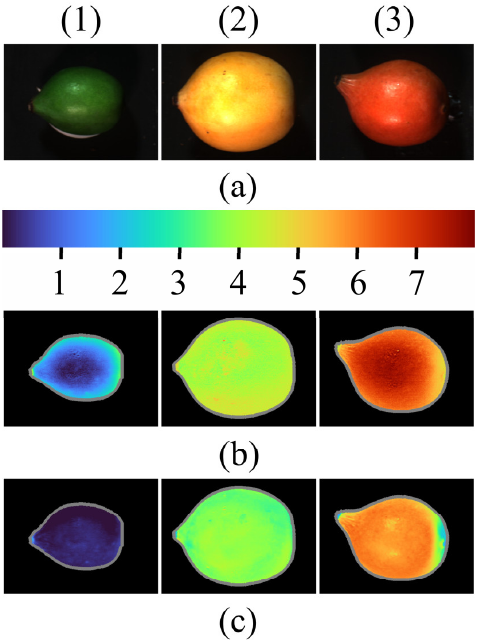
Figure 7. ( a ) RGB images of samples with low, medium and high ripeness stages. Ripeness values evaluated by using ( b ) PLSR and ( c ) SVR models.